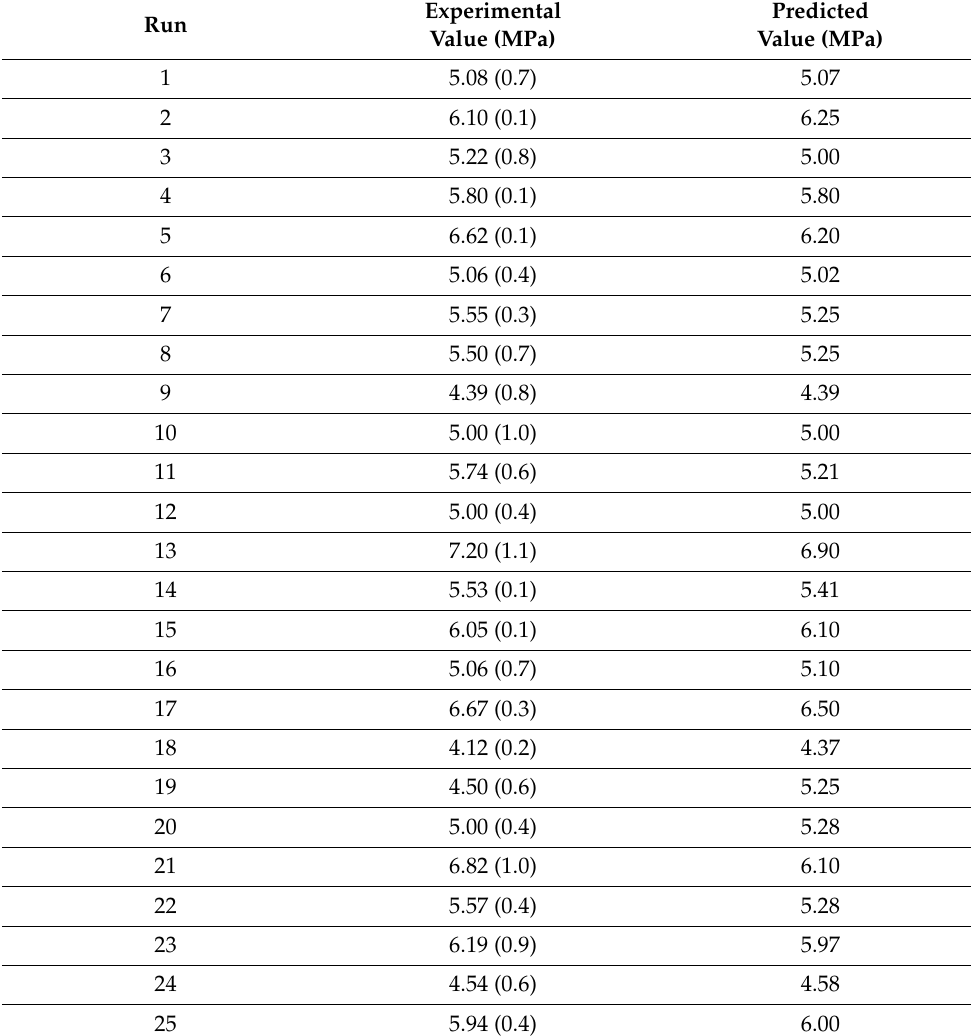
Table 3. Experimental values of bonding strength and values predicted by ANN.